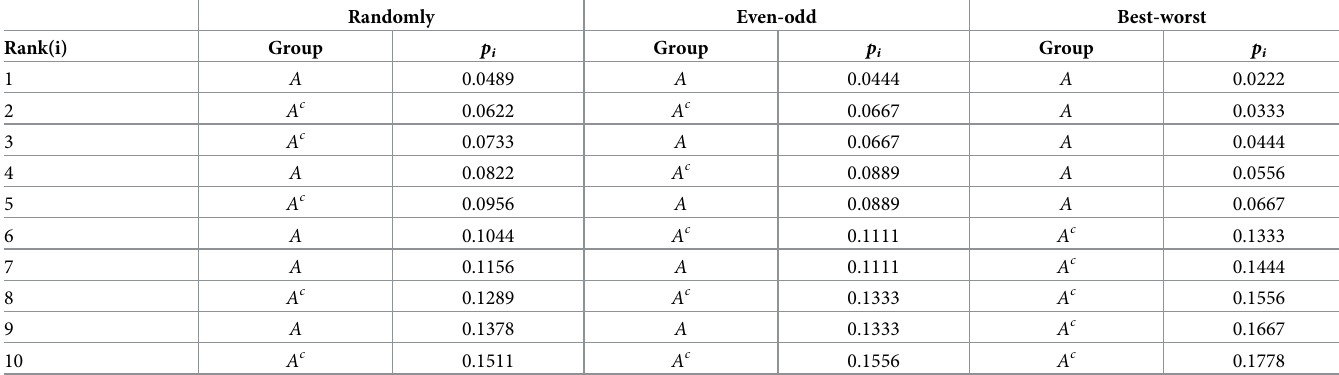
Table 1. Selection probabilities using various criteria in proposed